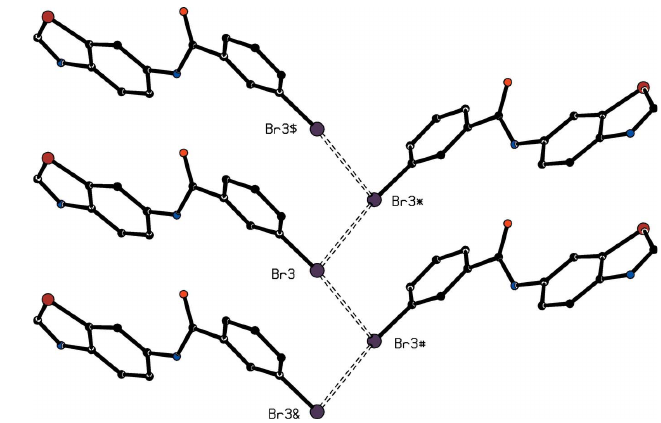
Figure 5 Part of the crystal structure of (I), showing a chain along ([010] containing two independent Br (cid:3)(cid:3)(cid:3) Br interactions (shown as dashed lines). For the sake of clarity, the H atoms and the unit-cell outline have been omitted. The Br atoms marked with an asterisk (*), a hash (#), a dollar sign ($) or an ampersand (&) are at the symmetry positions (2 (cid:5) x , 1 (cid:5) z ), ( x , 1 + y , z ) and ( x , (cid:5) 1 + y , z ), (2 (cid:5) x , (cid:5) 1 + y , 3 2 2